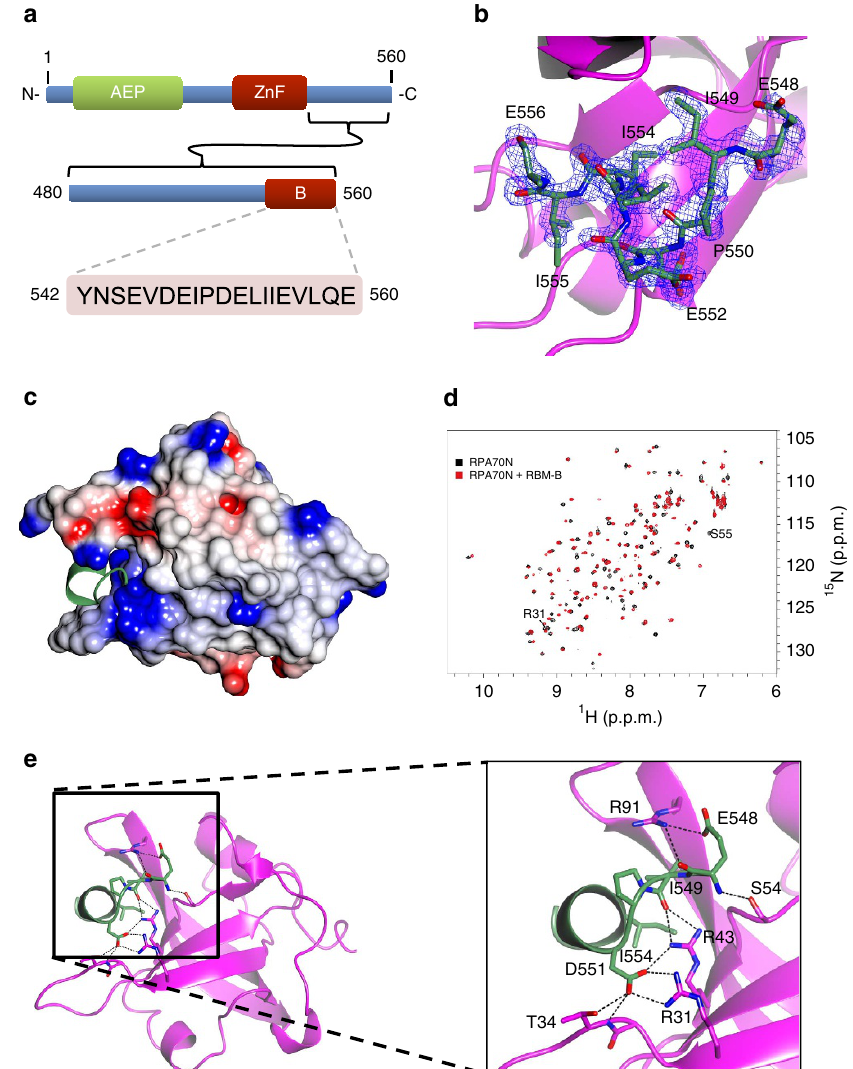
( c ) Electrostatic surface model of RPA70N with RBM-B (green) bound in the basic cleft. Basic and acidic surfaces are coloured blue and red, respectively. ( d ) 15 N- 1 H HSQC spectra showing RPA70N in the absence (black) or presence (red) of a twofold molar excess of unlabelled RBM-B peptide. ( e ) Key stabilizing interactions of RBM-B (green) in the RPA70N basic cleft (purple). RBM-B binds between b sheets in the b barrel of RPA70N. D551 is of particular importance as it forms a number of electrostatic interactions with both the side chains and a backbone amide NH of the RPA70N